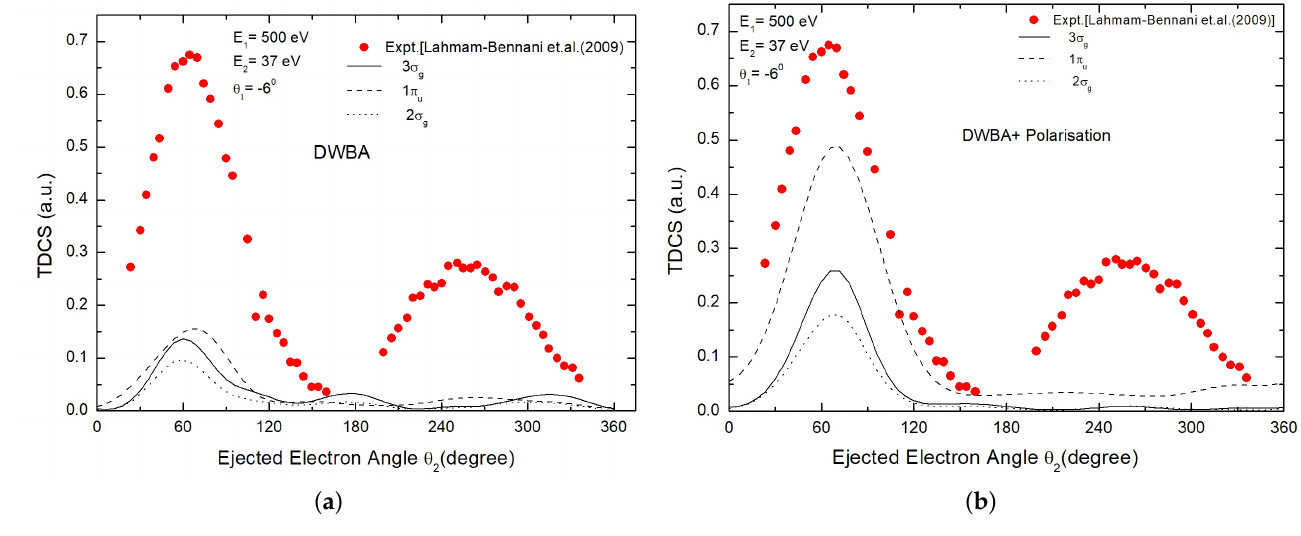
Figure 4. Electron-impact TDCS for N 2 molecule calculated for 3 σ g , 1 π u , 2 σ u valence orbitals. The ejected electron energy is 37 eV. ( a ) Individual orbital contribution for TDCS calculated by DWBA formalism, ( b ) shows contribution of individual orbital calculated by including polarisation potential. Kinematics and legends used are displayed in the figure